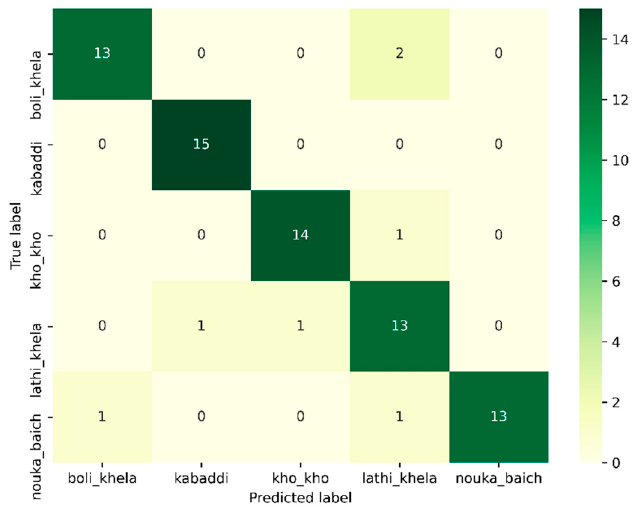
Figure 7. Confusion matrix for the scratch model. Table 3. Class ‐ wise performance of the scratch model.